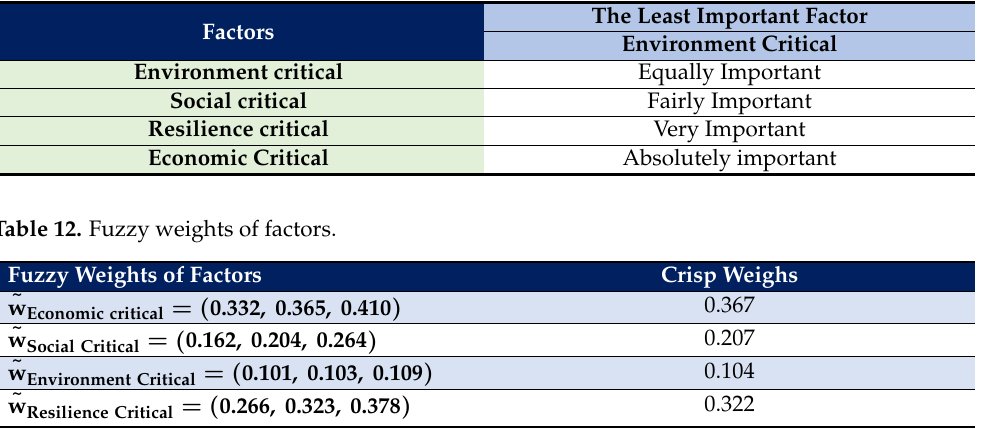
Table 11. The linguistic terms describing the fuzzy preferences of factors over the least important factor.